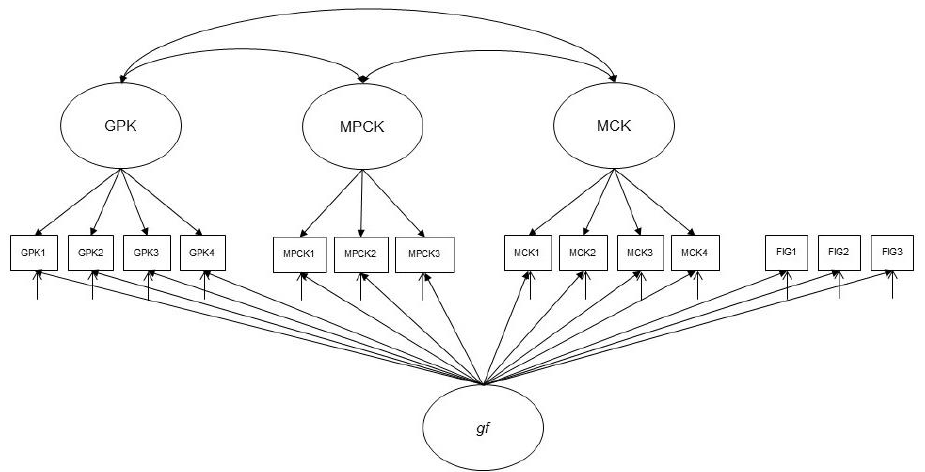
Figure 3. The bifactor (S-1) model (H4). Note. MCK = mathematics content knowledge; MPCK = mathematics pedagogical content knowledge; GPK = general pedagogical knowledge; gf = fluid intelligence.